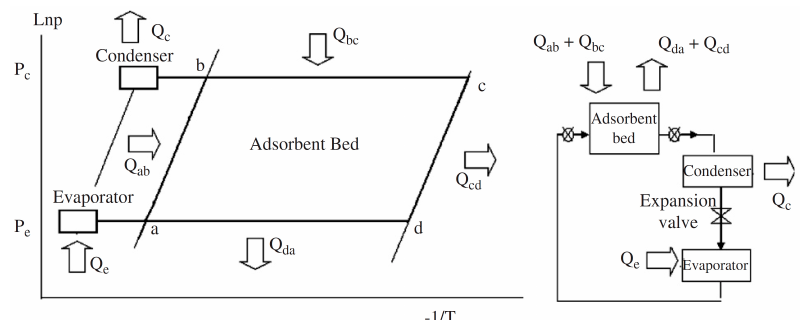
Figure 1. Thermodynamic cycle of a basic adsorption heat pump [10]. Details of the thermodynamic plot: isosteric heating (a–b); isobaric desorption (b–c); isosteric cooling (c–d); isobaric adsorption (d–a). (Copyright from Elsevier 2018).